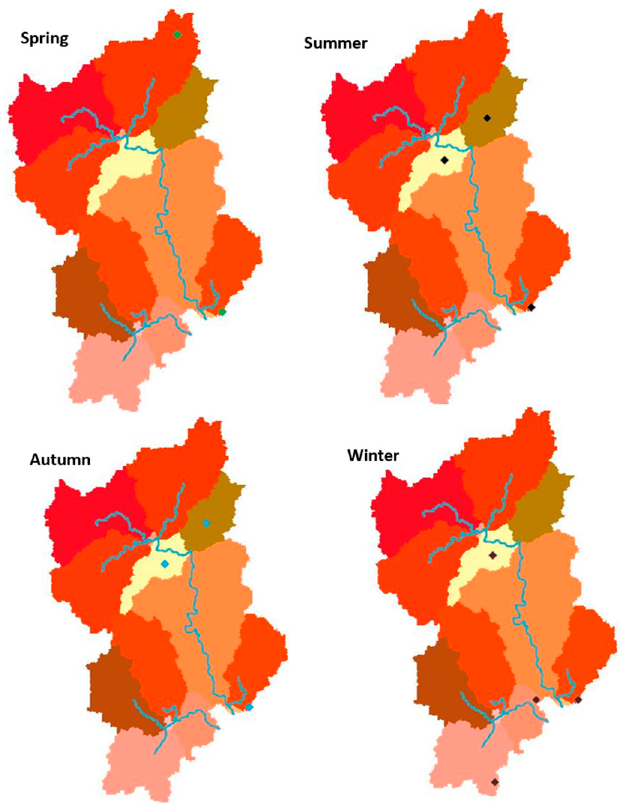
Figure 6. Seasonal changes in the spatial distribution of “critical locations”.